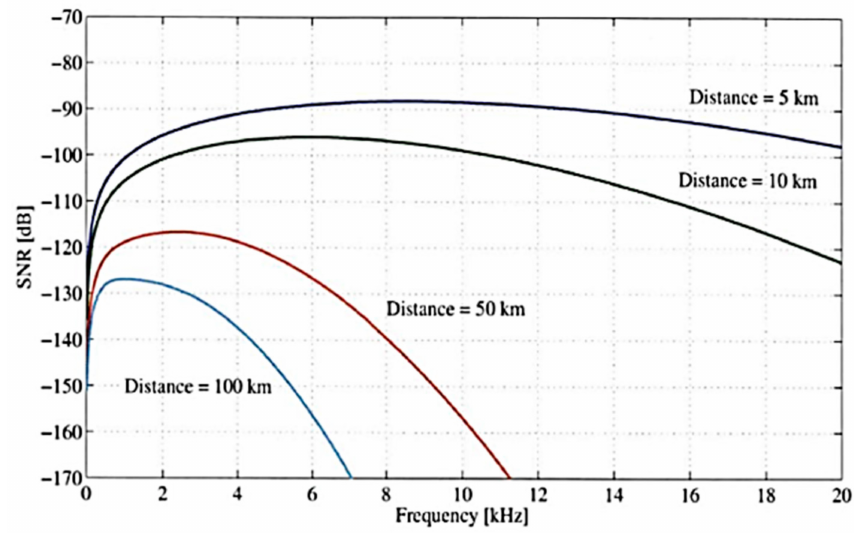
Figure 17. The range-dependent SNR for UWA links as a function of frequency